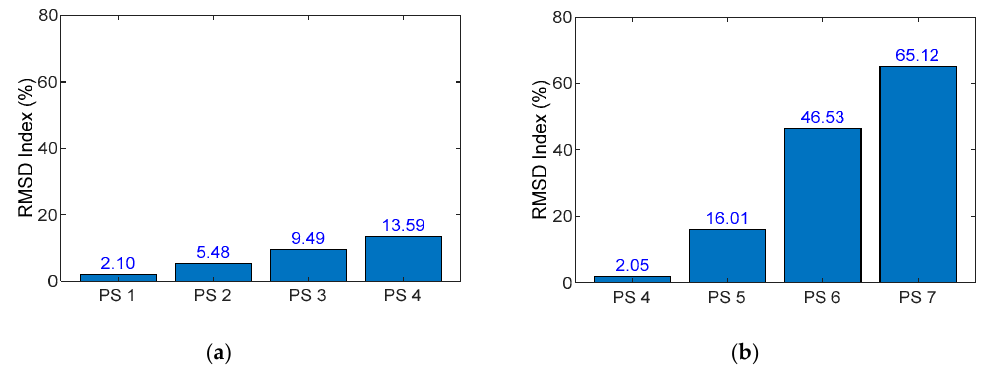
Figure 21. RMSD quantification of impedance responses under prestressing cases. ( a ) Prestressing cases of Strand 9: PS1–PS4 and ( b ) prestressing cases of Strand 1: PS4–PS7.